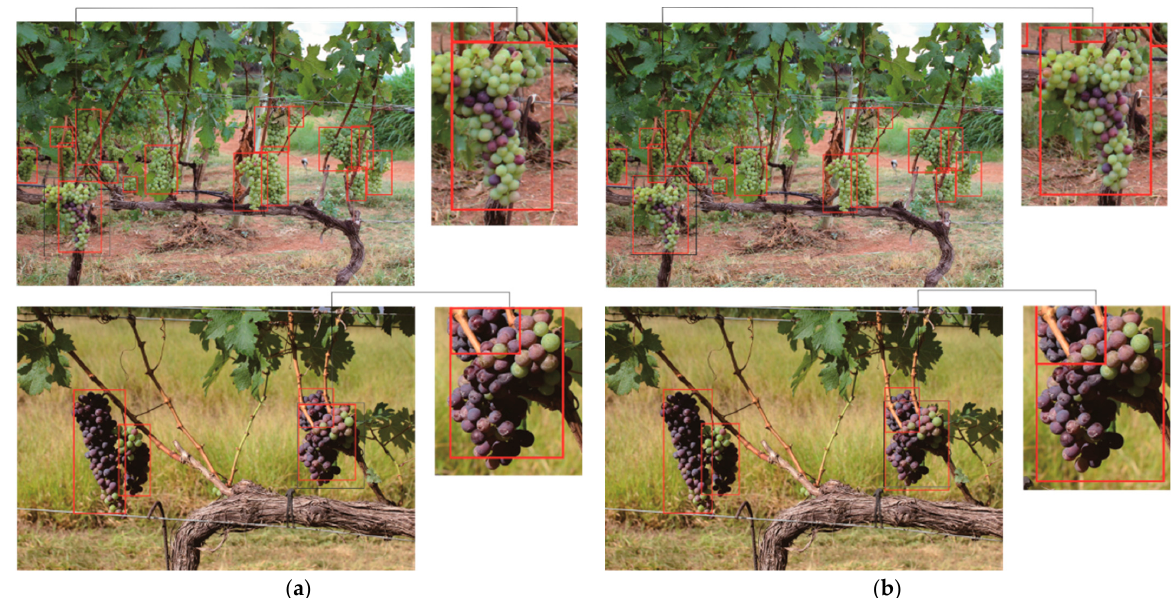
Figure 11. The detection results under different non-maximum suppression algorithms. ( a ) NMS; ( b ) R-NMS.